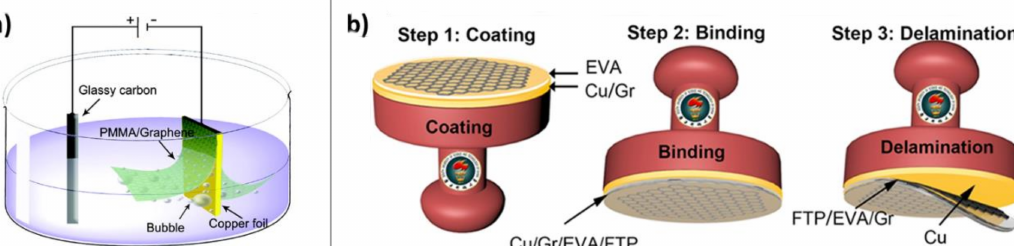
Figure 7. Bubble transfer methods. ( a ) Experimental electrode setup for electrochemical generation of hydrogen bubbles between the original substrate and the graphene to increase the graphene-substrate distance and weaken the adhesion energy. Adapted with permission from Ref. [33]. Copyright 2011 American Chemical Society. ( b ) An alternative experimental setup with non-PMMA support for graphene. Adapted under the terms of the Creative Commons Attribution 4.0 License from Ref. [88]. Copyright 2019, the